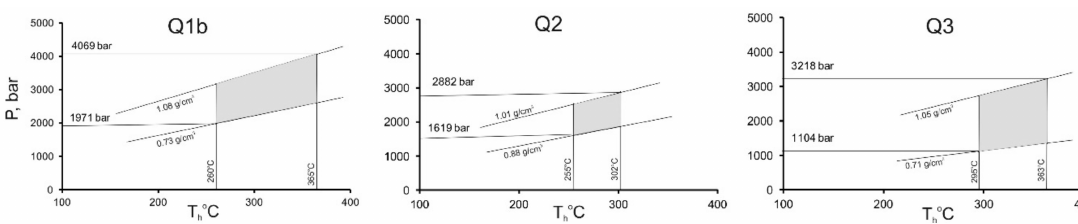
Figure 11. Estimated fluid pressure in the Svetlinsk